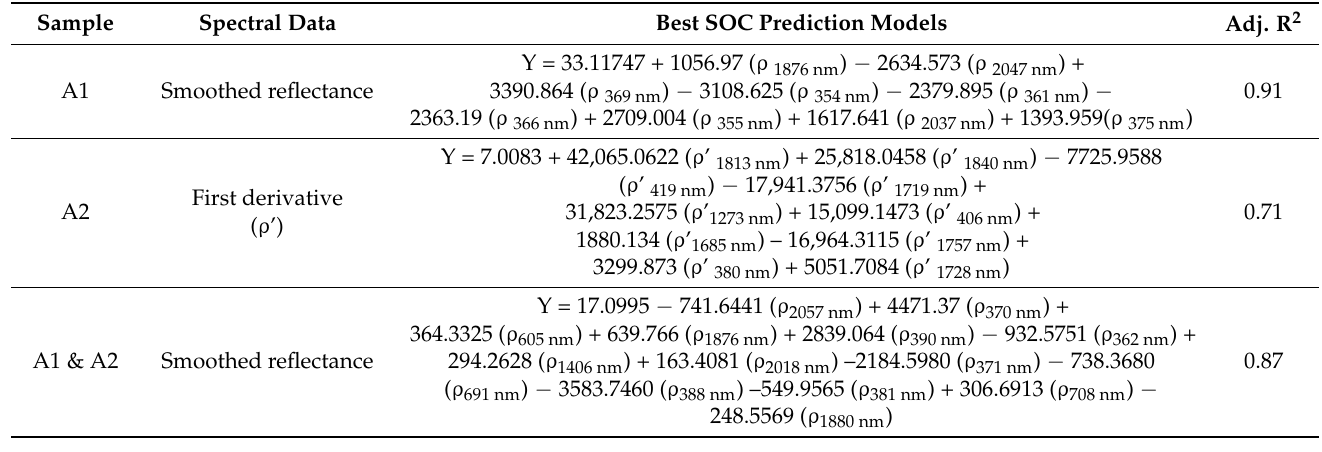
Table 8. Equations for SOC prediction (g kg − 1 ) with the best models constructed using PLSR for each sample subset, including the respective adjusted R 2